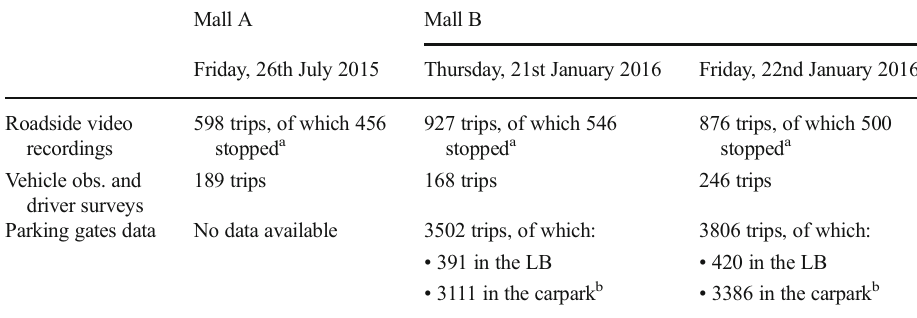
Table 2 Number of vehicle-trips recorded Mall A Mall